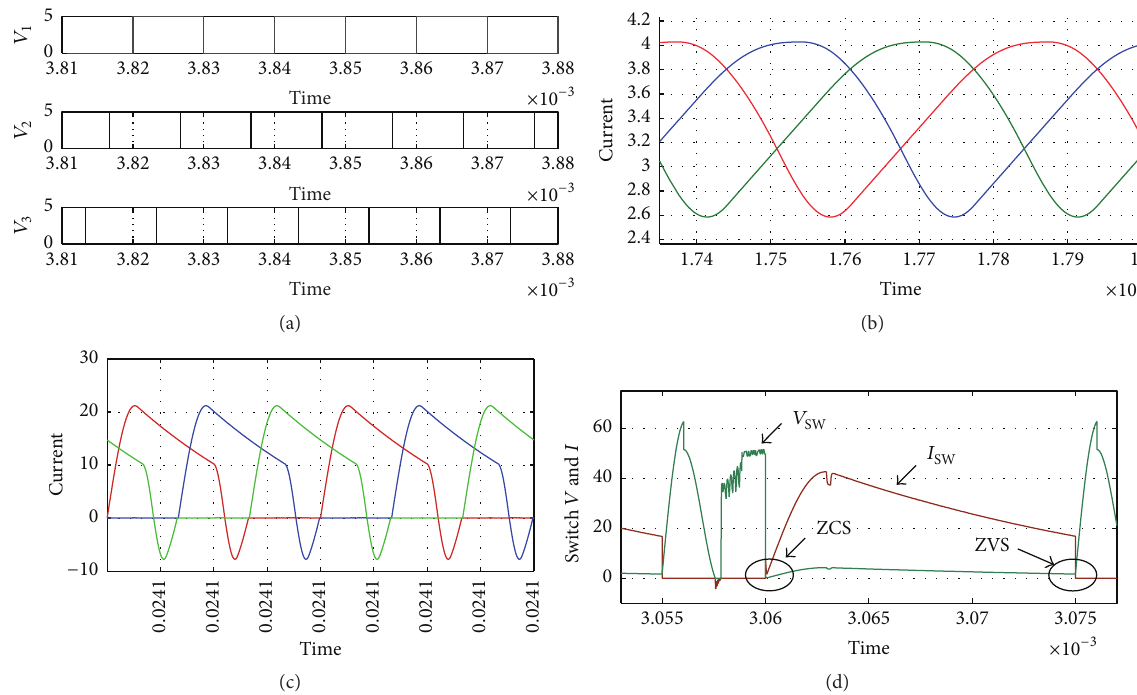
Figure 16: Voltage and current waveforms of TSSSBC. (a) Driving pulses. (b) Main inductors current. (c) Resonant inductors current. (d) Voltage and current through the switch.